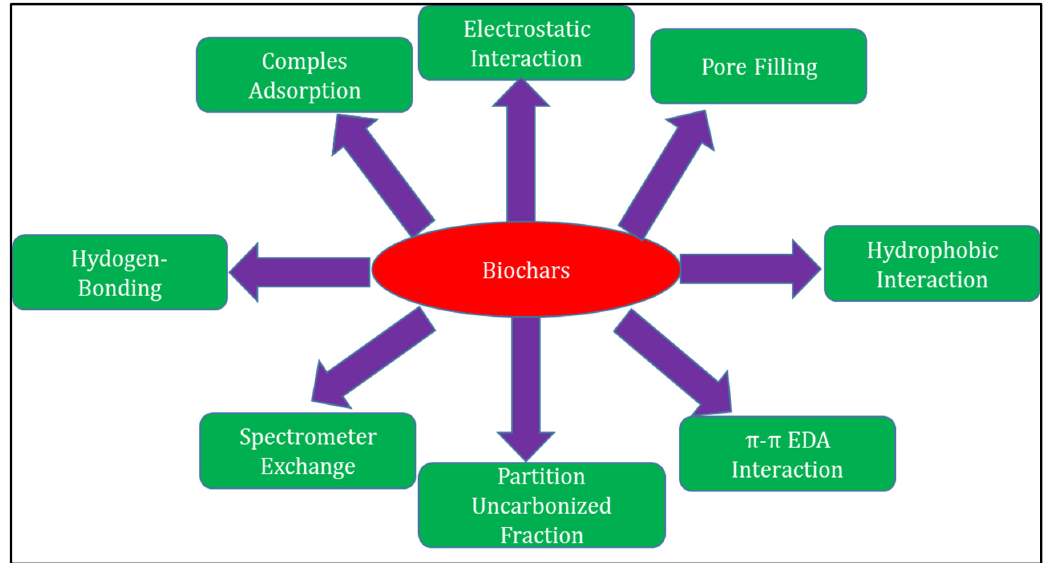
Figure 2. The mechanism of the adsorption of organic pollutants on biochars [8].